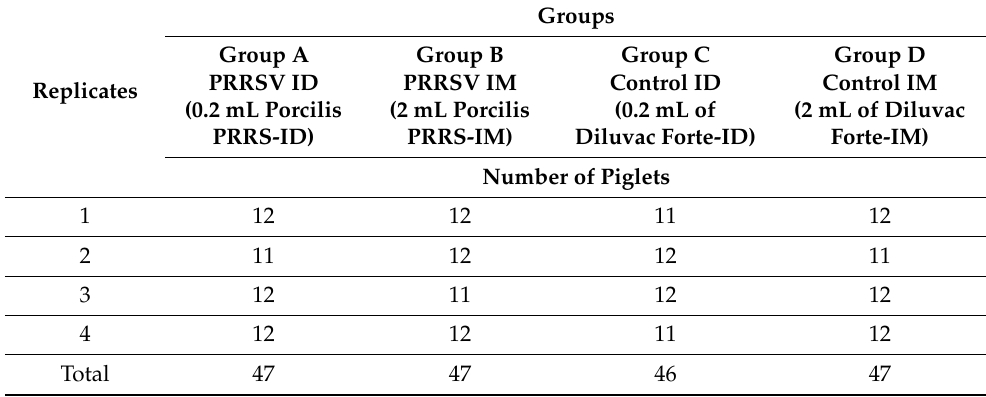
Table 1. Vaccinated and non-vaccinated groups during the trial (replicates and numbers of the piglets.